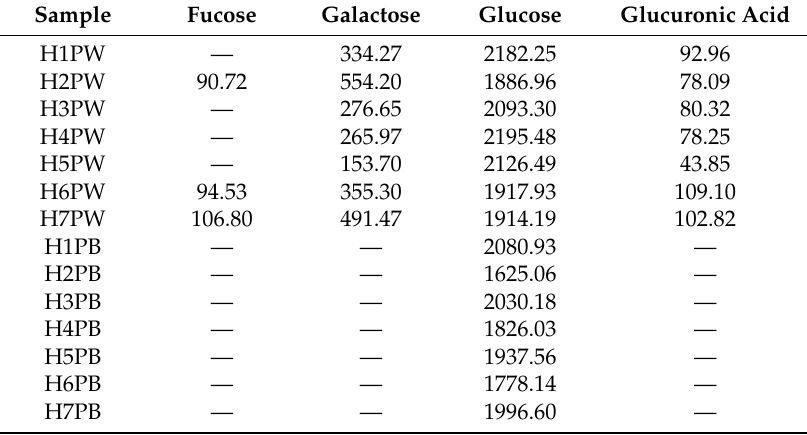
Table 2. Monosaccharide composition of water-soluble and alkaline-soluble cell wall polysaccharides from Hericium erinaceus fruiting bodies at different growth